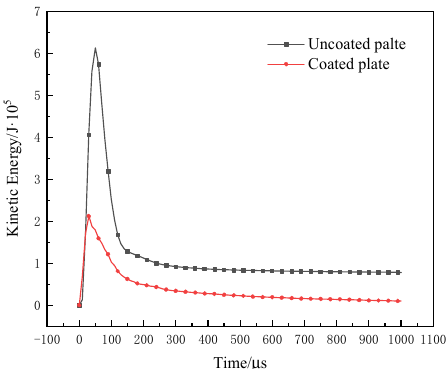
Figure 20. Kinetic energy curves of coated and uncoated reinforced concrete slabs.